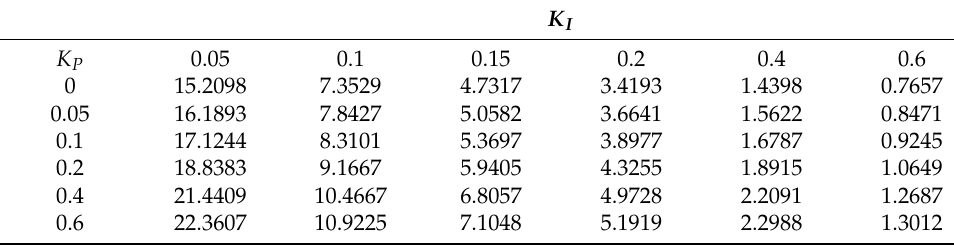
Figure 6. The frequency deviation with G m = 1, Φ m = 30 ◦ , K P = 0.2 and K I = 0.2. Table 7. Delay margin ( G m = 1, Φ m = 45 ◦ ).